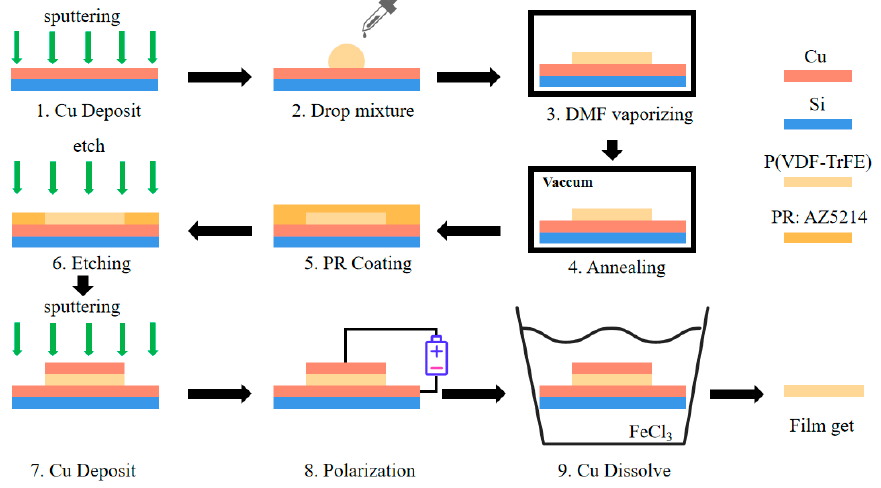
Figure 1. Fabrication process for P(VDF-TrFE) film.